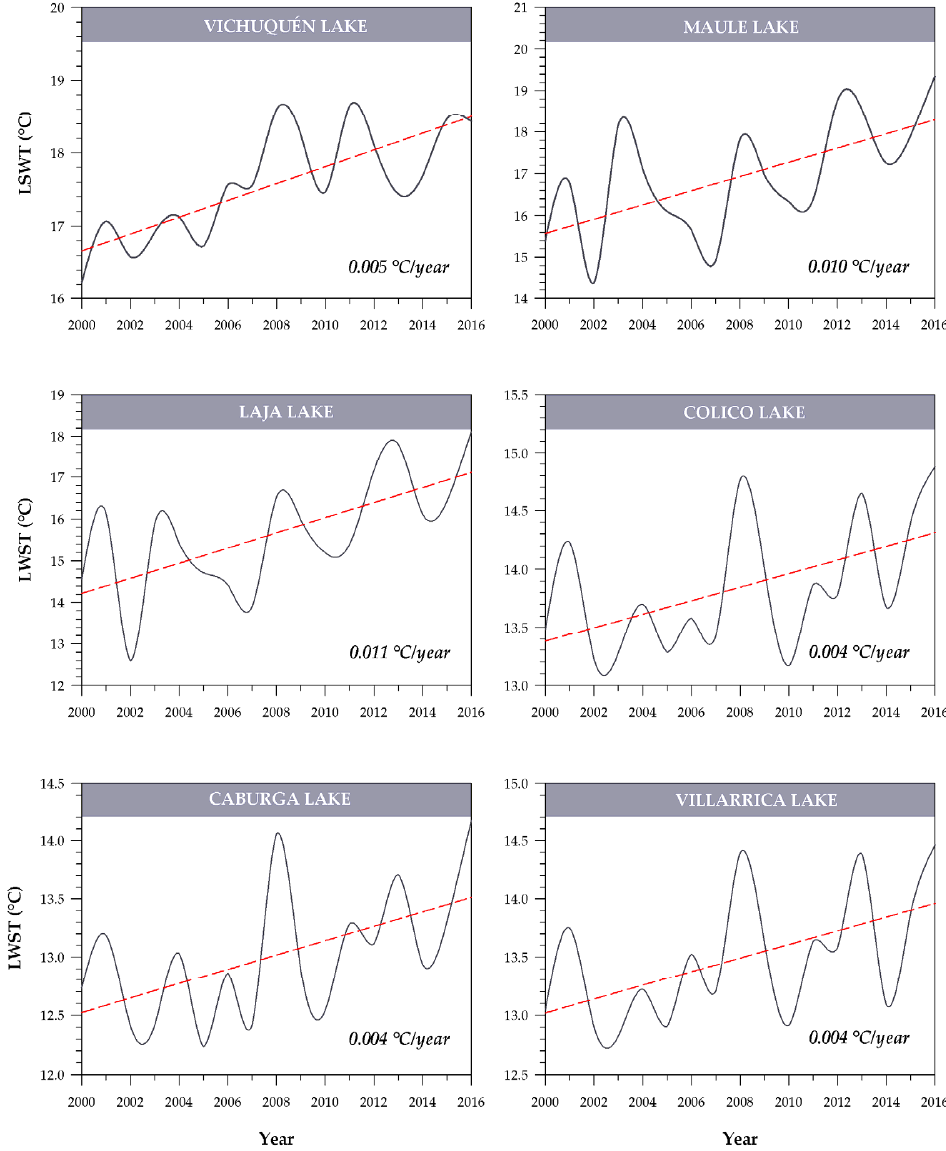
Figure 2. Temporal behavior and trends of the annual MODIS LSWT series.